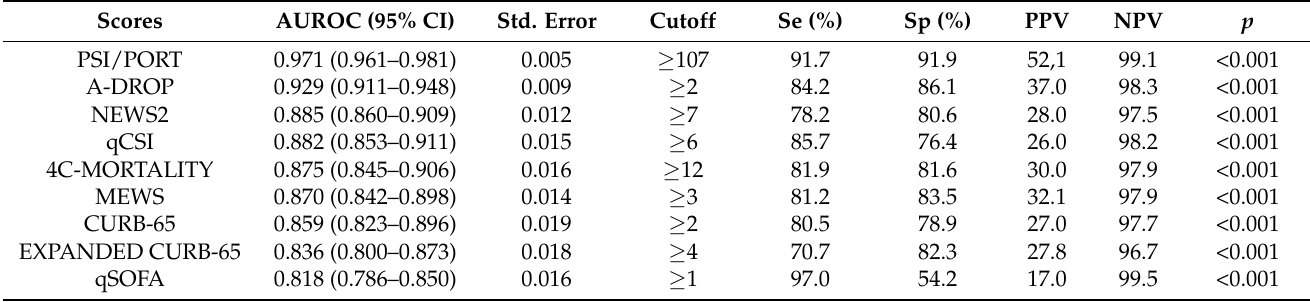
Table 5. Discriminative accuracy of scores in predicting hospital